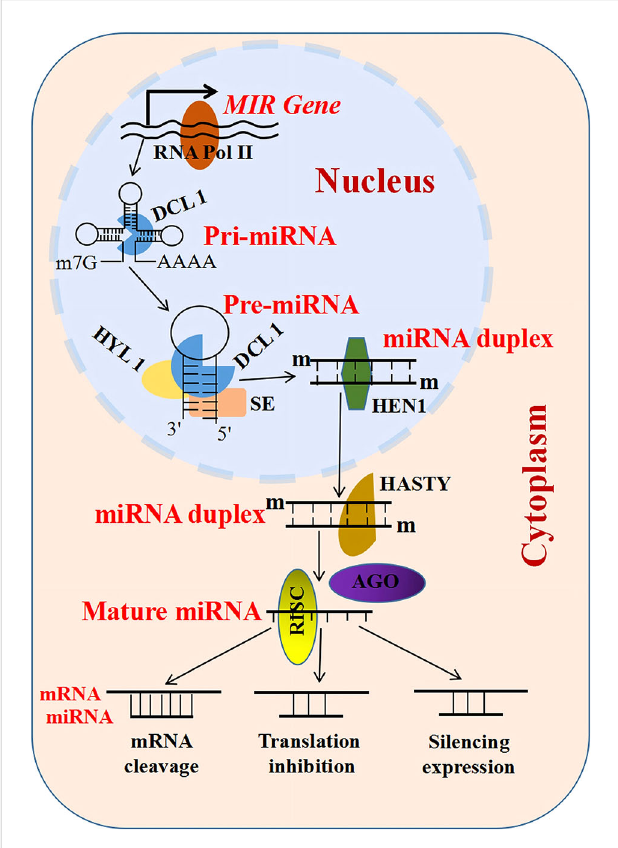
FIGURE 1 Characteristic features of microRNAs (miRNAs) and long non-coding RNAs (lncRNAs). Biosynthesis and mode of action of miRNAs: primary miRNAs (pri-miRNAs) self-fold and are complementarily paired to